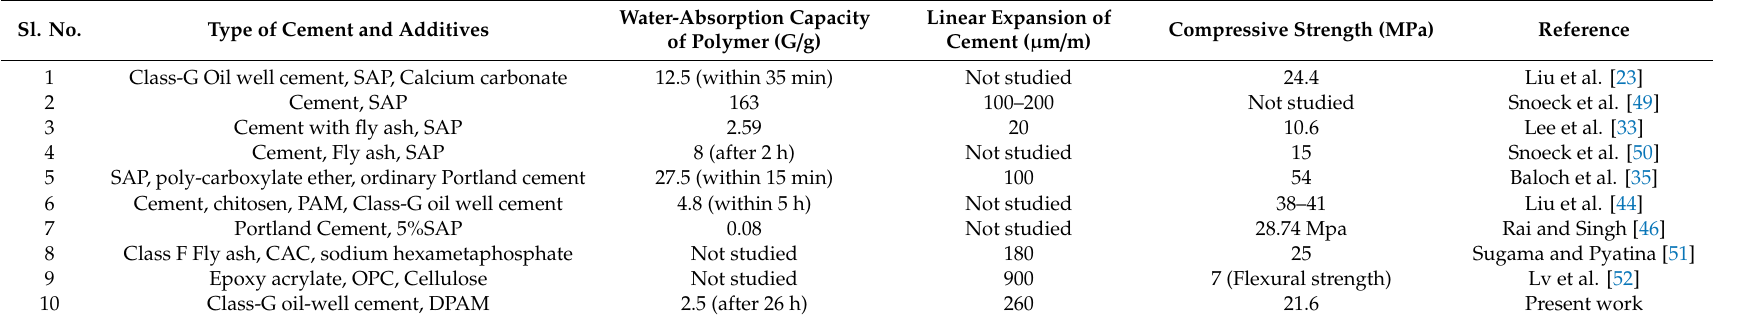
Table 3. Comparison of the results with the earlier reported